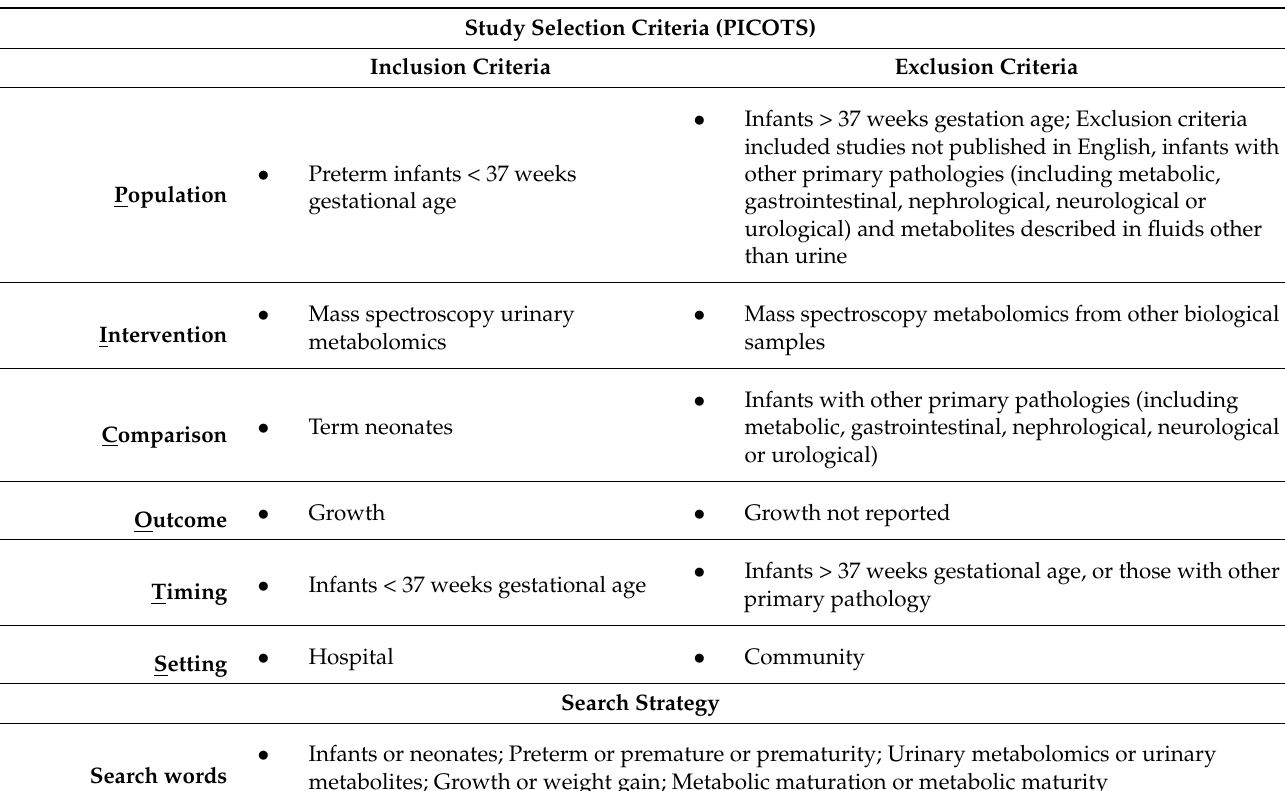
Table A2. Search strategy for PuBMed and study inclusion criteria to